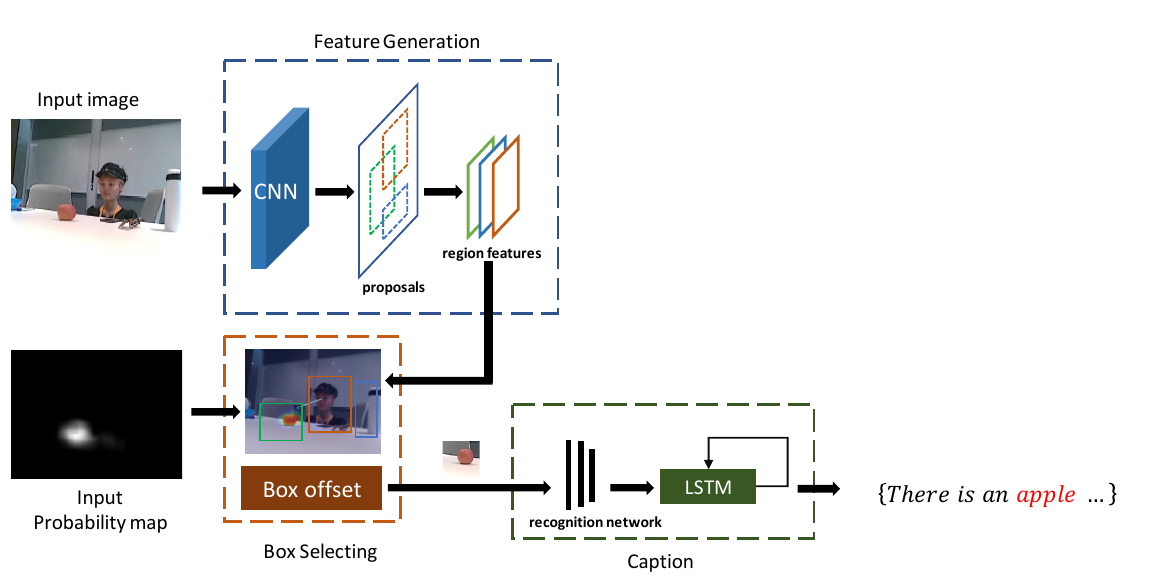
Figure 4. The framework of attention-based object description method.